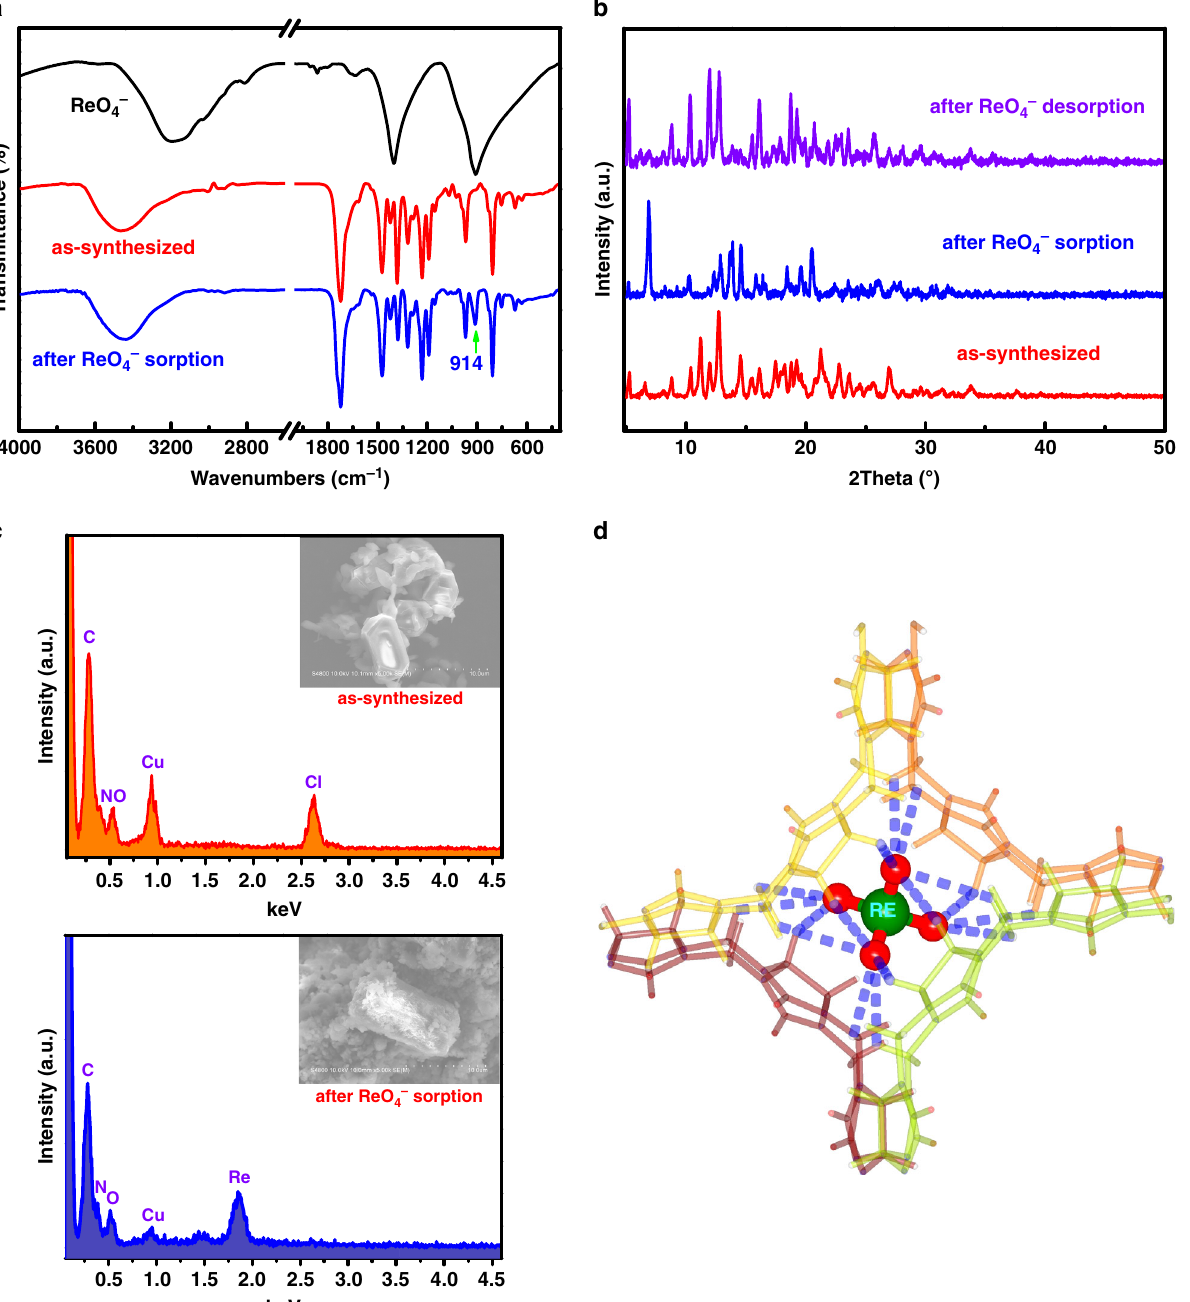
Fig. 6 Characterization of SCP-IHEP-1 after ReO 4 − sorption. a IR spectra of SCP-IHEP-1 before (red) and after (blue) ReO 4 − exchange; b PXRD patterns before ReO 4 − sorption (red), after ReO 4 − sorption (blue) and after material recovery by ReO 4 − desorption in a solution of 0.5 M NaNO 3 (purple); c EDS of SCP-IHEP-1 before (top) and after (bottom) ReO 4 − exchange; d ReO 4 − instead of NO 3 − trapped in a tetrahedral coordination cavity after ReO 4 − sorption (four adjacent CB8 molecules are shown in different colors and hydrogen atoms in